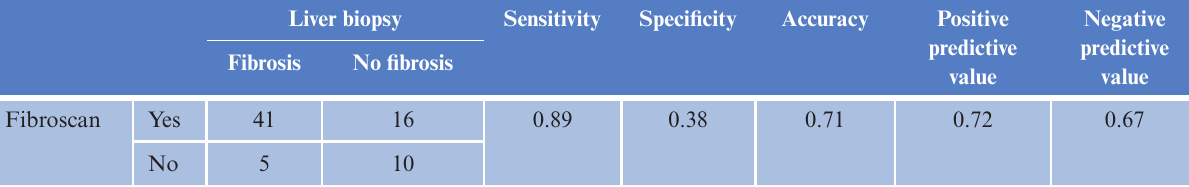
The values represent the number of